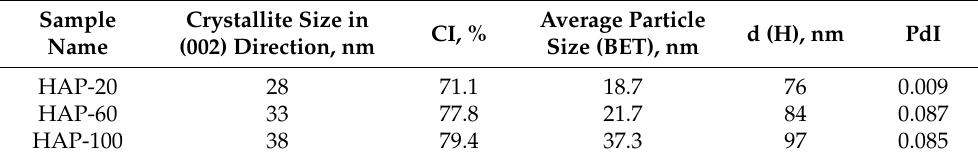
Table 4. Scherrer crystallite size, BET average particle size, and hydrodynamic diameter of HAP